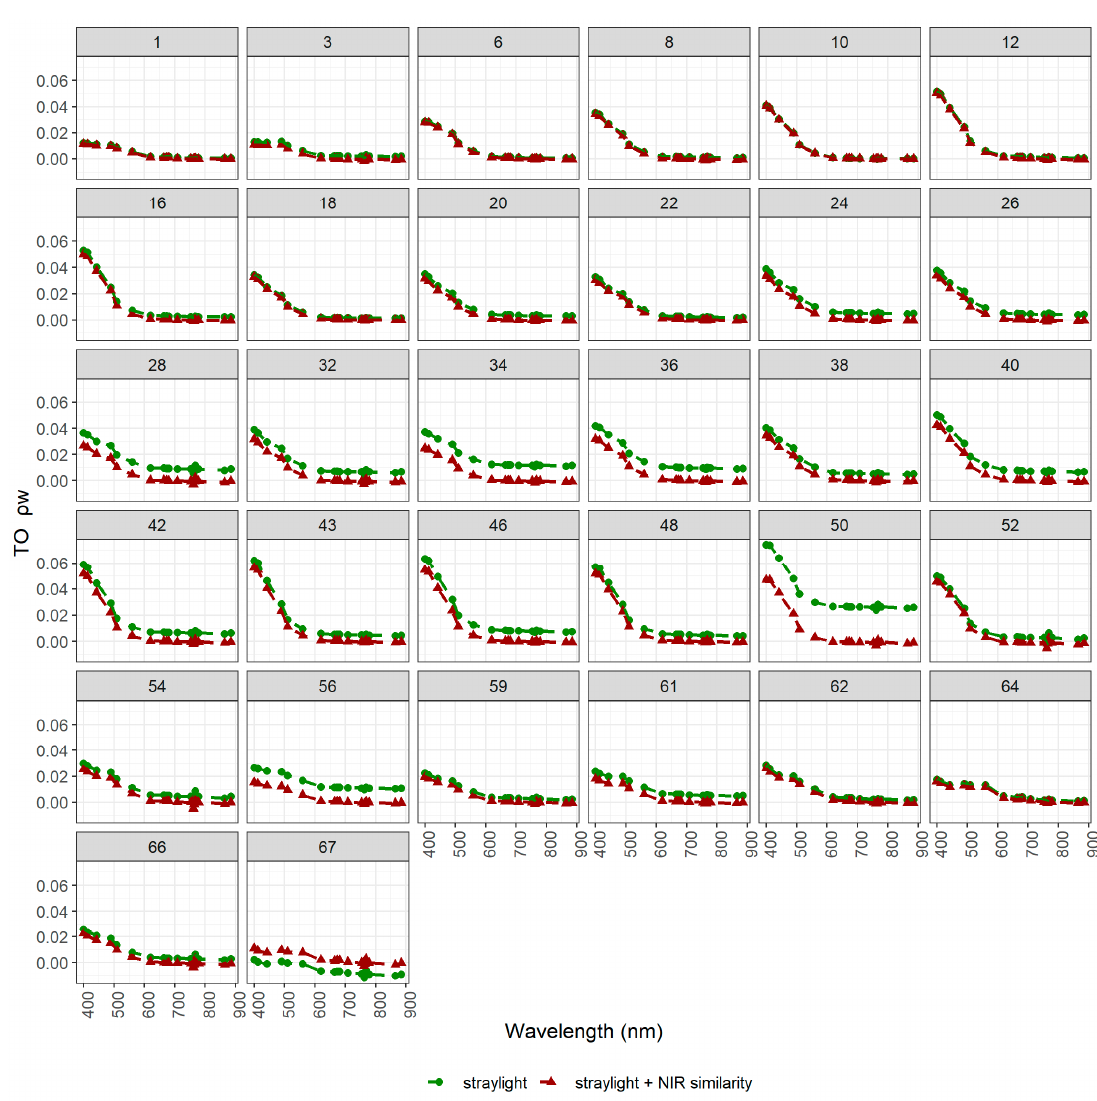
Figure A1. ρ w ( λ ) spectra at each measurement station corrected for straylight (green circles) and after the straylight and NIR similarity correction (brown triangles). More data from each station can be found in Table